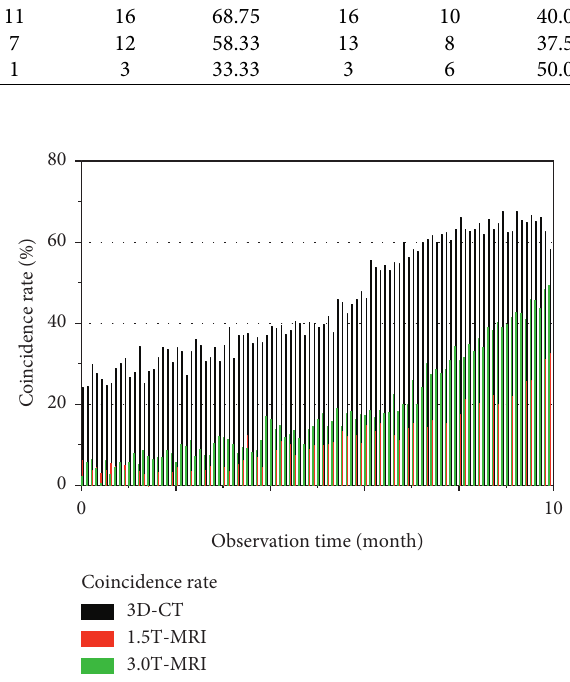
Figure 9: Coincidence rate for different reconstruction methods at different recovery